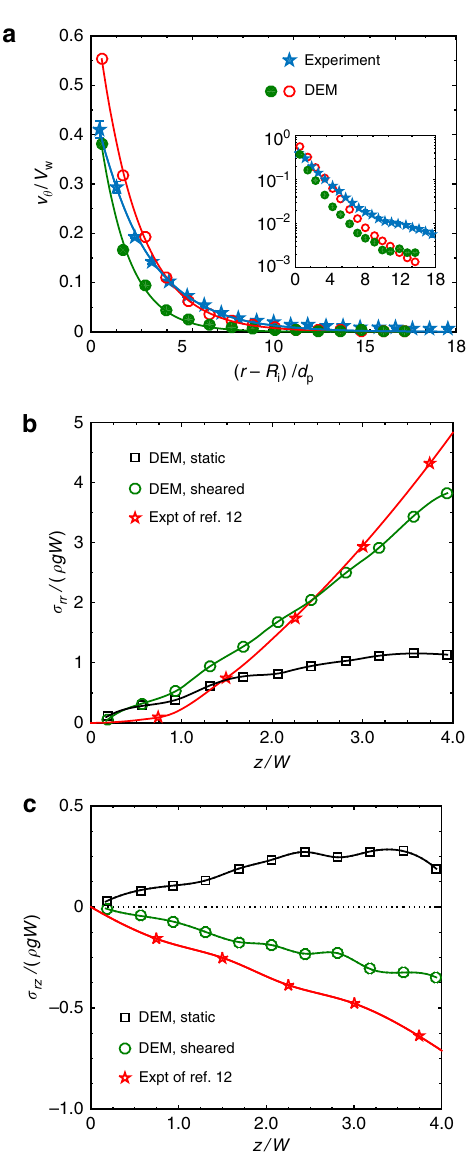
Figure 2 | Validation of the DEM simulations. ( a ) The azimuthal velocity v y (scaled by V w (cid:5) R i O ) at the free surface as a function of radial distance from the inner cylinder; the inset shows the same plot in linear-log scale. The green filled circles are for rough walls, and the red open circles are for smooth walls. The lines are exponential fits v y ¼ v 0 exp[ (cid:3) ( r (cid:3) R i )/ b ] of the data, with b ¼ 2.5 d p (experiment), 2 d p (DEM, rough walls) and 1.5 d p (DEM, smooth walls). The error bars, indicating one standard deviation about the mean, are obtained from eight independent measurements; error bars for the DEM simulations are smaller than the size of the symbols. ( b , c ) Variation with depth of the normal stress and the vertical shear stress on the outer cylinder for static and sheared columns with rough walls; here r is the average bulk density in the Couette cell. The lines are cubic spline fits of the data, and the experimental data are from ref. 12. In all the panels, the DEM results are for H ¼ 90 d p